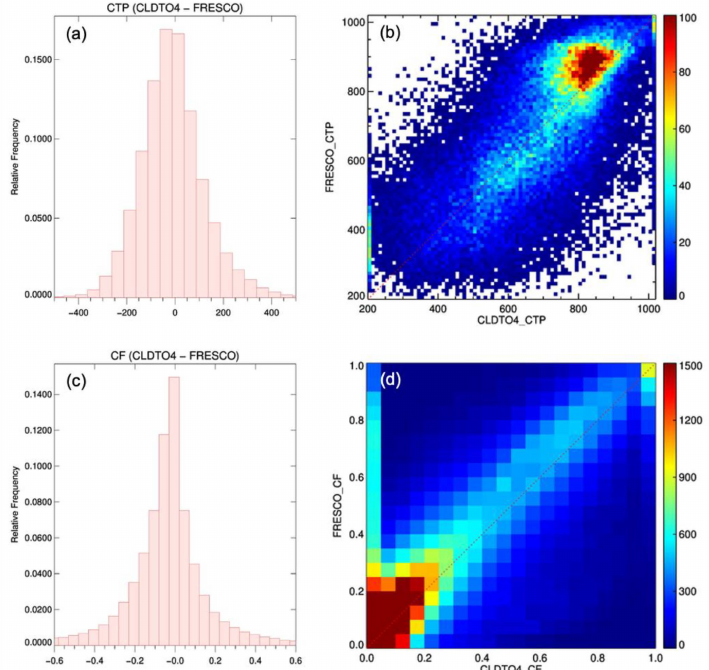
Figure 7. ( a ) Histogram of bias and ( b ) density plot for CTP. ( c ) Histogram of bias and ( d ) density plot for